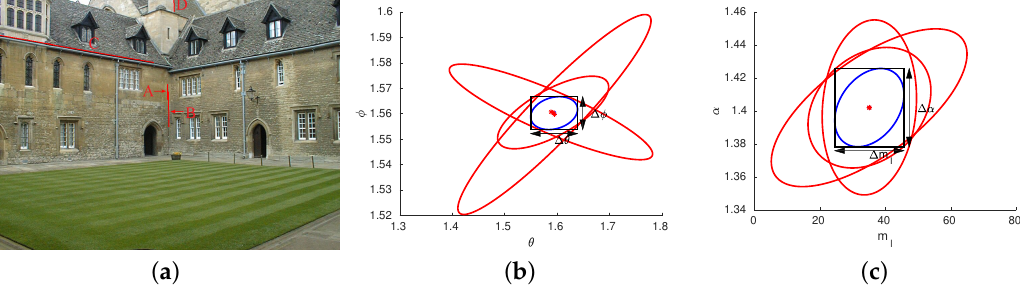
Figure 11. Example of uncertainty estimation, fusion and visualization for line reconstruction. By fusing these noisy estimations, a posterior estimation with smaller uncertainty can be obtained. The uncertainty of direction and position are visualized by 95% confidence region. ( a ) Four example line segments are labelled on the image, the corresponding confidence interval length of each component are reported in Table 2. ( b ) Uncertainty estimation and fusion of direction components for A. ∆ θ and ∆ φ correspond to 95% confidence interval lengths of θ and φ , respectively. ( c ) Uncertainty estimation and fusion of positional components for A. ∆ m l and ∆ α are the confidence interval lengths of positional components m l and α